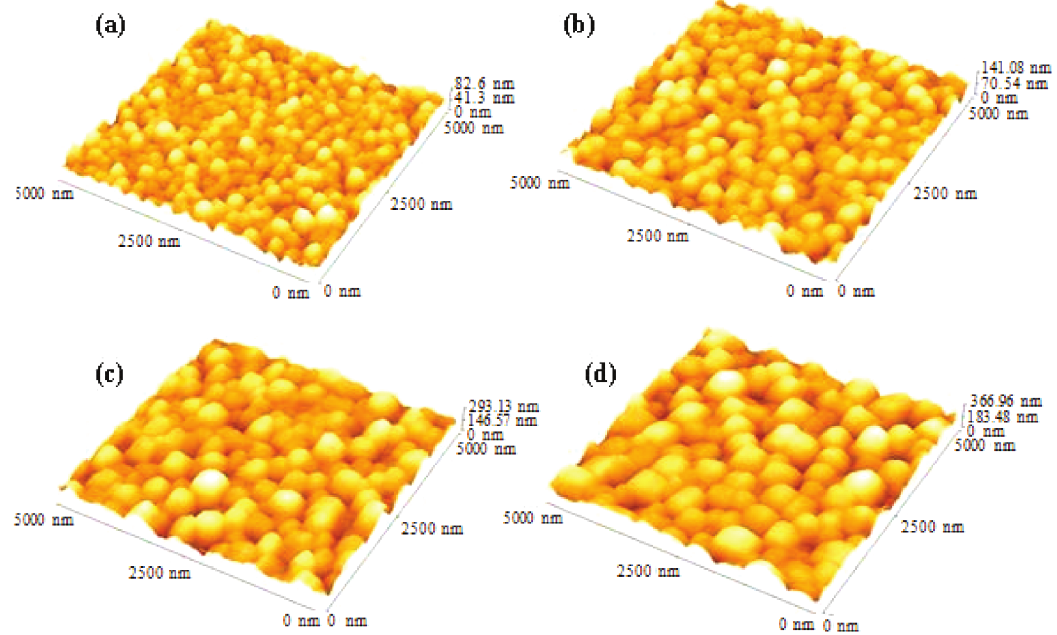
Figure 3: AFM images of nickel films with different thickness after pretreatment process (a) 5 nm, (b) 10 nm, (c) 15 nm, (d) 20